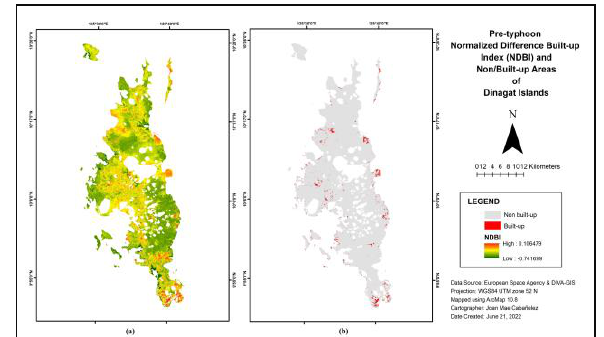
Figure 9 . NDBI and built-up layers of Dinagat Islands during pre-typhoon condition.